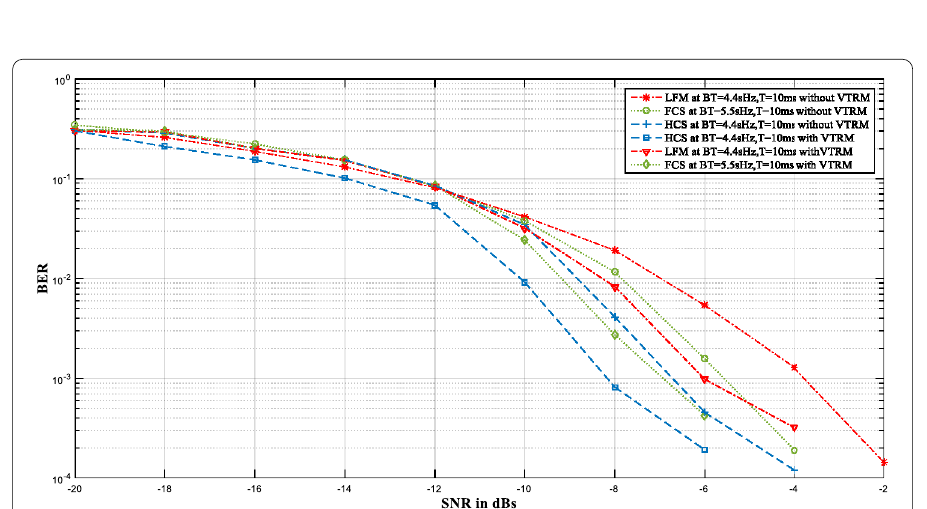
Fig. 12 BER versus SNR graph of HCS Chirp, FCS chirp and LFM with SF 4.4sHz and 5.5, respectively, and Chirp Period 10